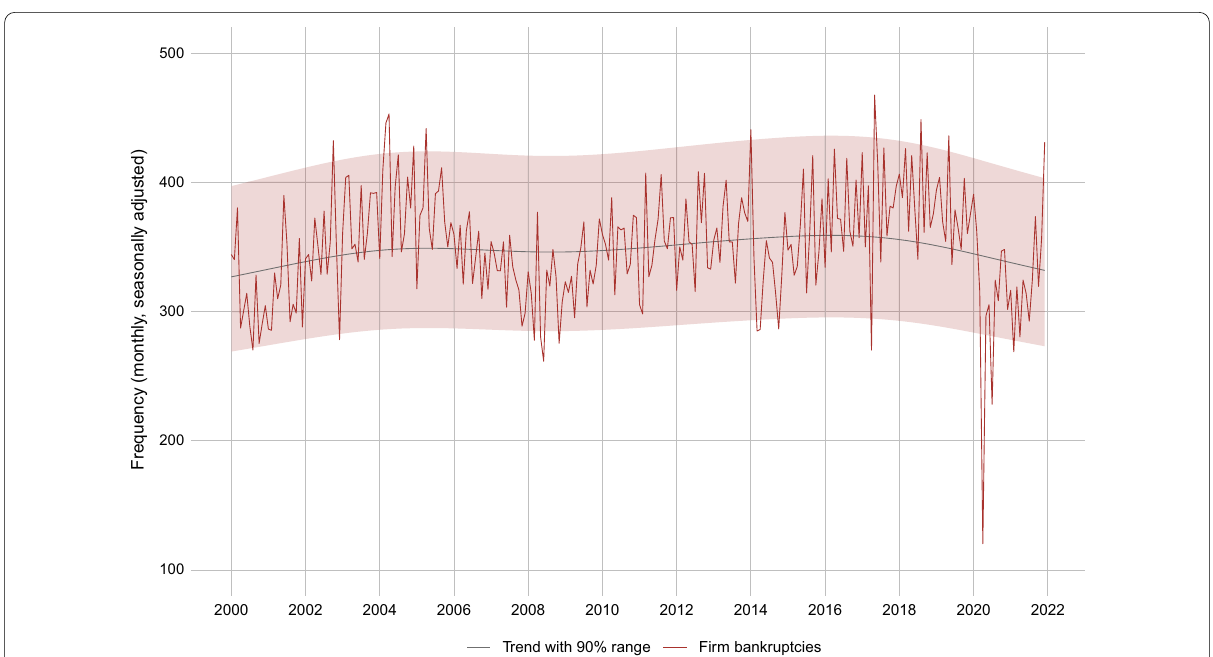
Fig. 3 Monthly frequency of firm bankruptcies in Switzerland. Notes : The figure shows the monthly seasonally adjusted frequency of total firm bankrupcties in Switzerland excluding SCO Art. 731b cases, together with a trend and the 90% probability range